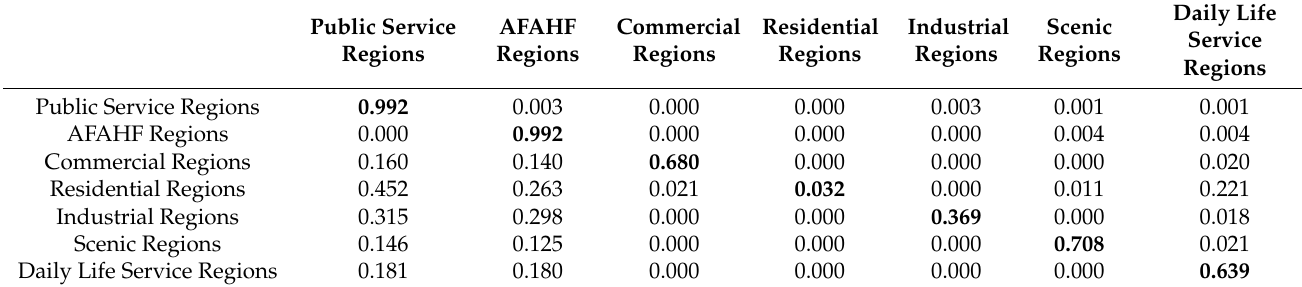
Table 7. Confusion matrix of identification result based on GPTEM.